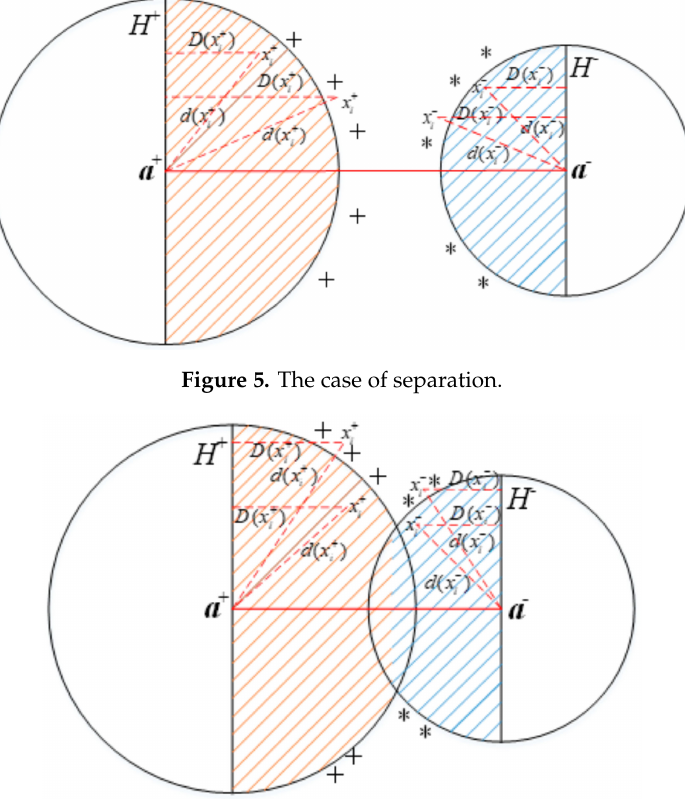
Figure 6. The case of